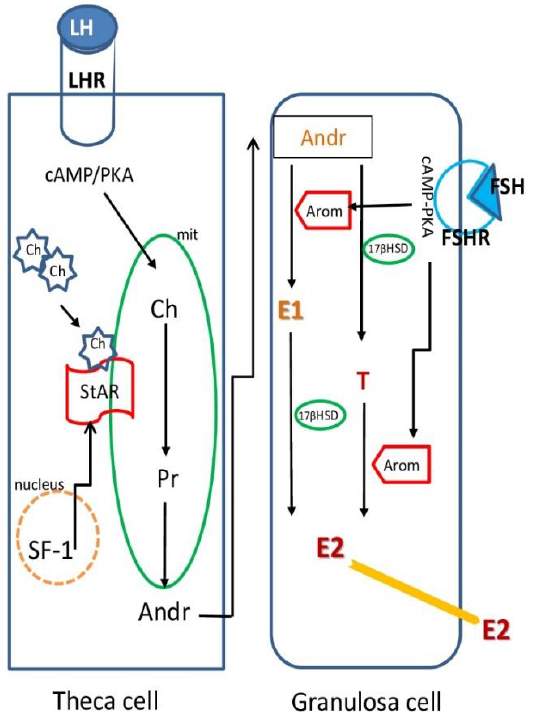
Figure 2. Two cell, two-gonadotropin theory. Ovarian steroids are synthesized from cholesterol (CH) via the cooperation of theca and granulosa cells. In theca cells, LH and its receptor (LHR) stimulate androgen synthesis via Gαs-mediated increases in cAMP that, in turn, activates PKA. This kinase can increase steroidogenic acute regulatory protein (StAR) expression and activity in collaboration with the orphan nuclear receptor Steroidogenic factor-1 (SF-1) an), which acts as a global regulator of steroidogenesis. StAR moves cholesterol (Ch) into the mitochondria (mit), where it is converted to progesterone (Pr) and then androstenedione (Andr). In granulosa cells, FSH and FSHR stimulate the activity of 17βhydroxysteroid dehydrogenase (17βHSD) and aromatase, which produce estron (E1) and estradiol (E2) from Andr and T (testosterone).